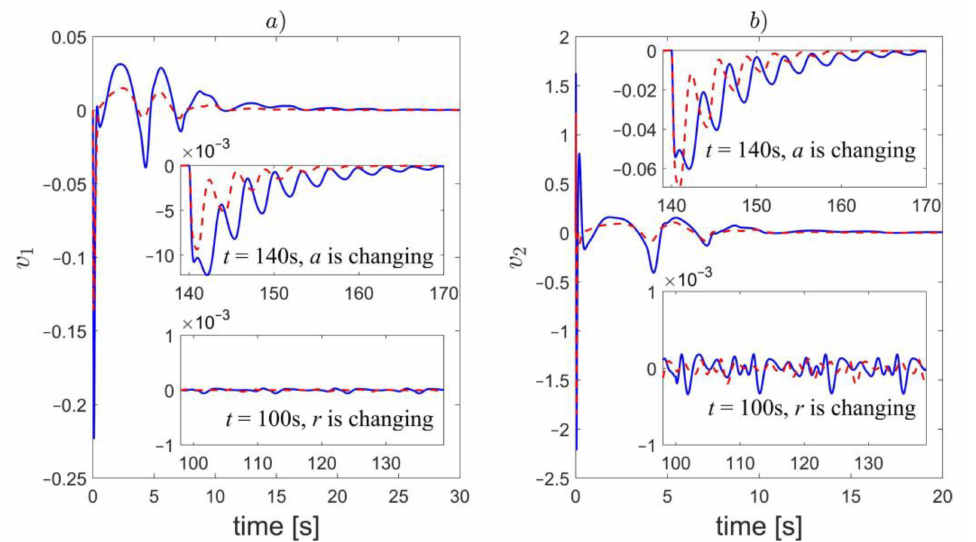
Figure 8. ( a ) Tracking/synchronization error v 1 = x 1 − w 1 ; ( b ) tracking error v 2 ; design parameters: K 1 = K 2 = K 3 = 10, solid line; design parameters: K 1 = K 2 = K 3 = 15, dashed